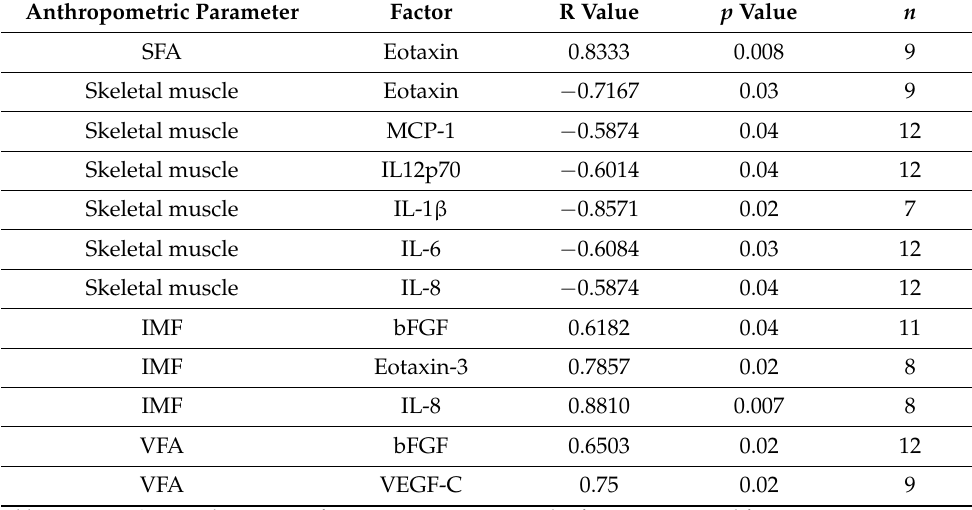
Table 2. Anthropometric parameters correlating with secreted factors from VAT.